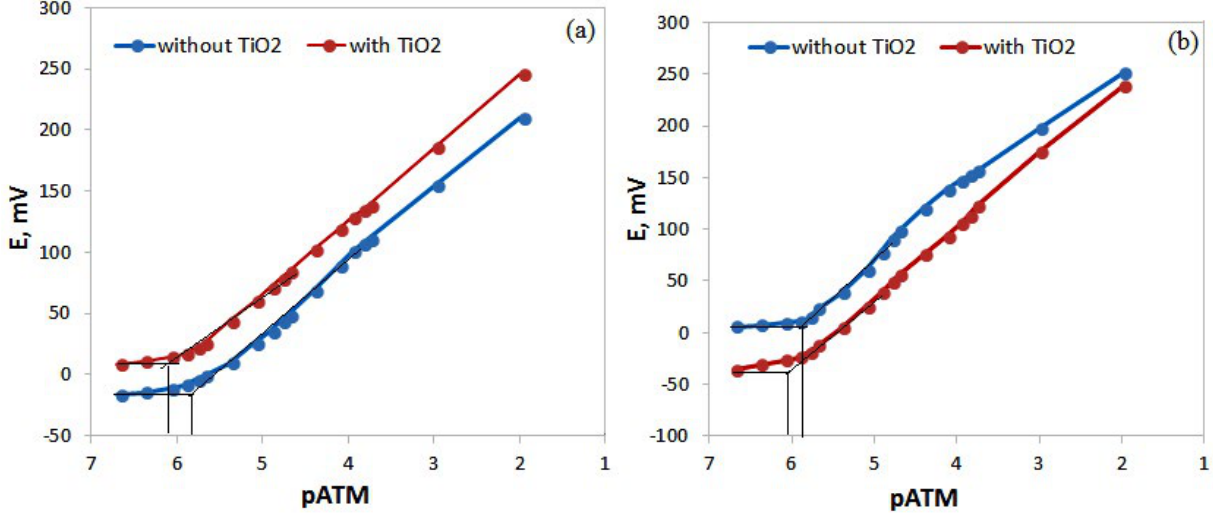
Fig. 3. Calibration graph and limit of detection of (a) ATM-TPB and (b) ATM-PTA electrodes with and without TiO 2